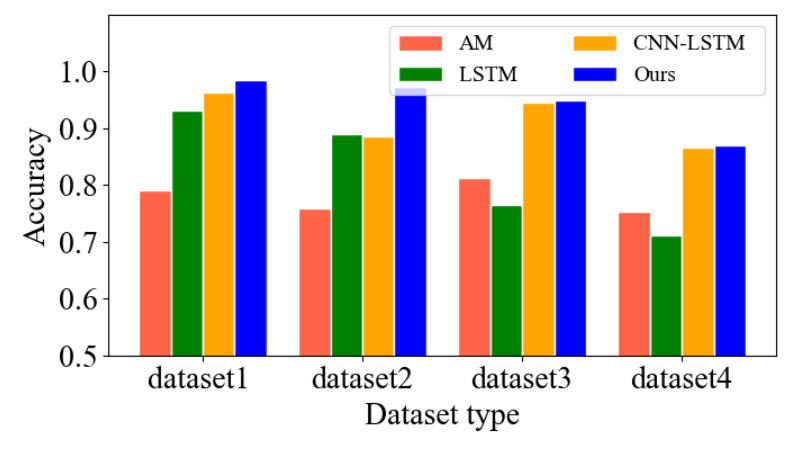
Figure 16. Prediction accuracy of different models in different datasets.